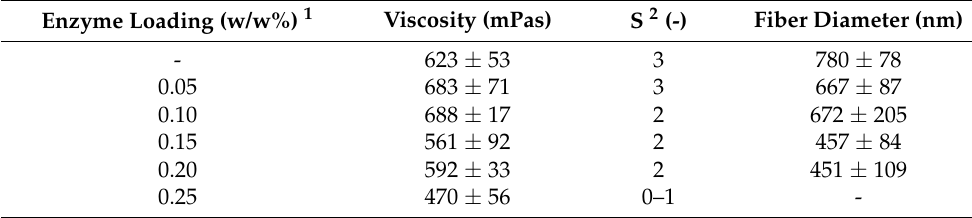
Table 1. The effect of the amount of enzyme solution (enzyme loading) on the viscosity of precursor mixture, fiber formation, and diameter of